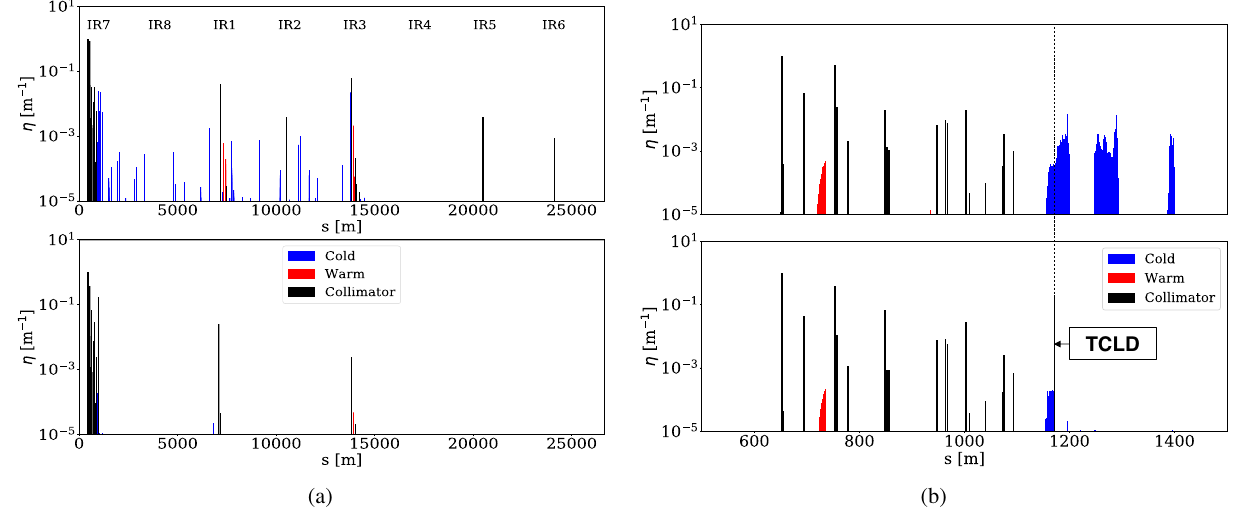
FIG. 17. Horizontal B1 full ring (a) and IR7 zoom (b) loss map for the 2018 LHC (top) and HL-LHC (bottom) 208 Pb 82 þ ion operation layout.